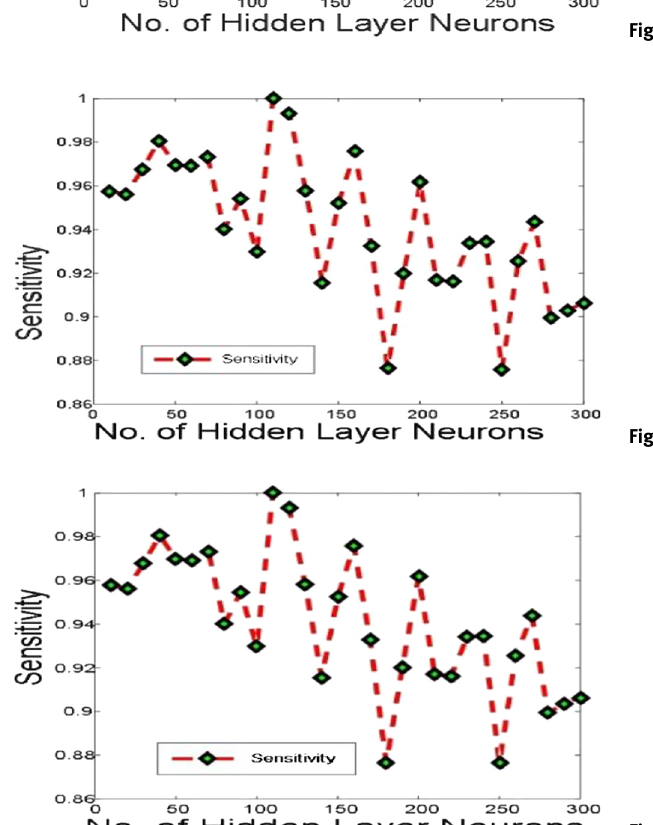
Figure 11: Sensitivity in TLBO-ELM.